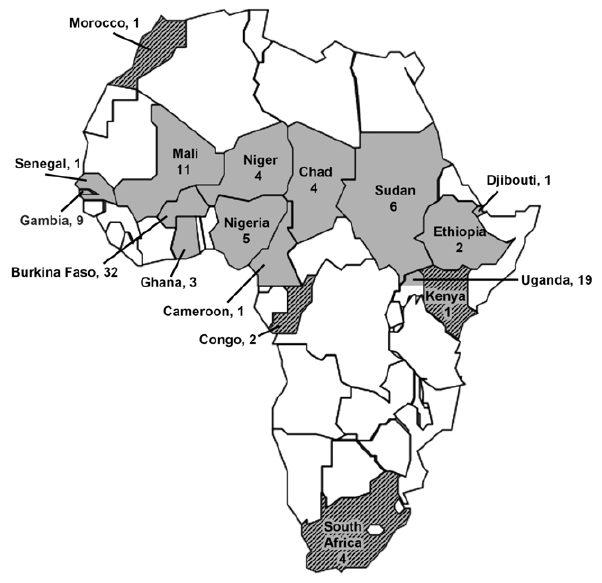
Figure 1. Map of Africa showing the source countries (gray) for the isolates and the number of isolates from that country. Countries shown in gray with hatches are from outside the meningitis belt. Gulu district in northern Uganda is part of the meningitis belt (see text).